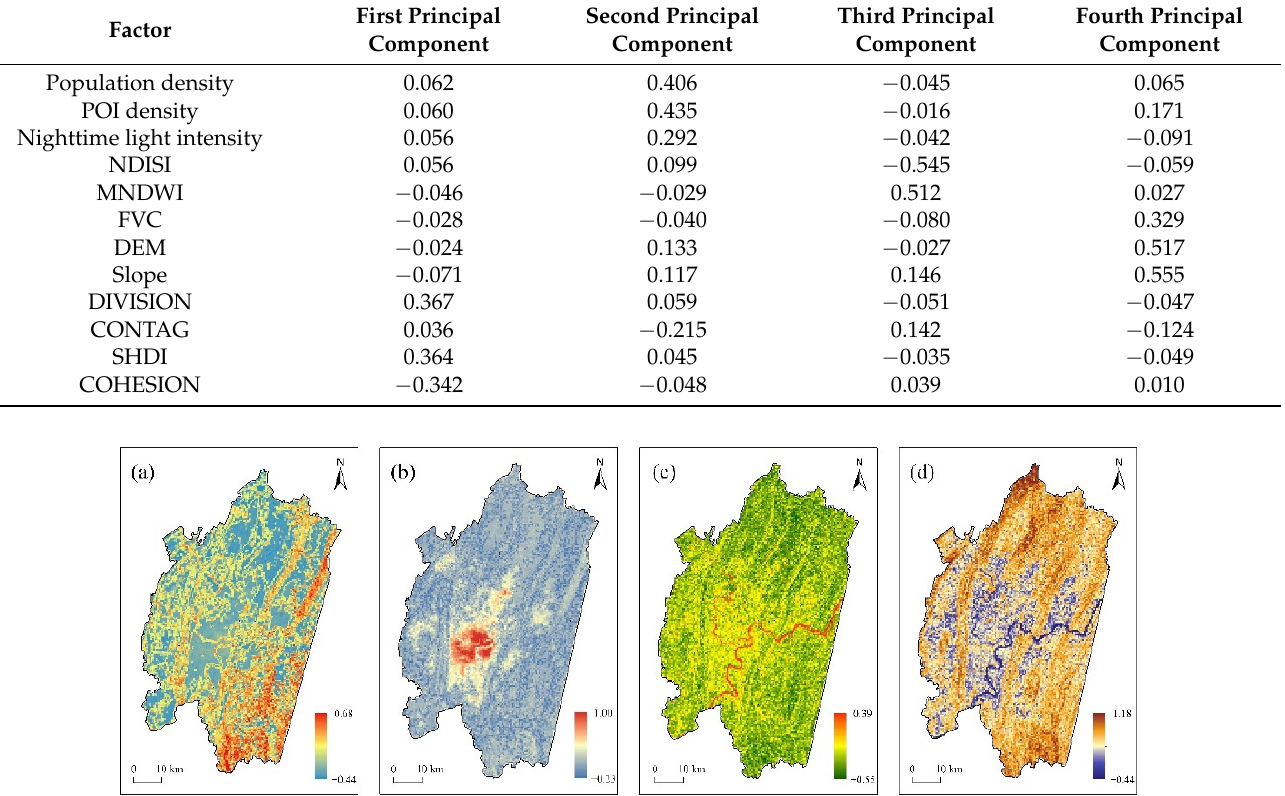
Table 5. Principal component score loading matrix.